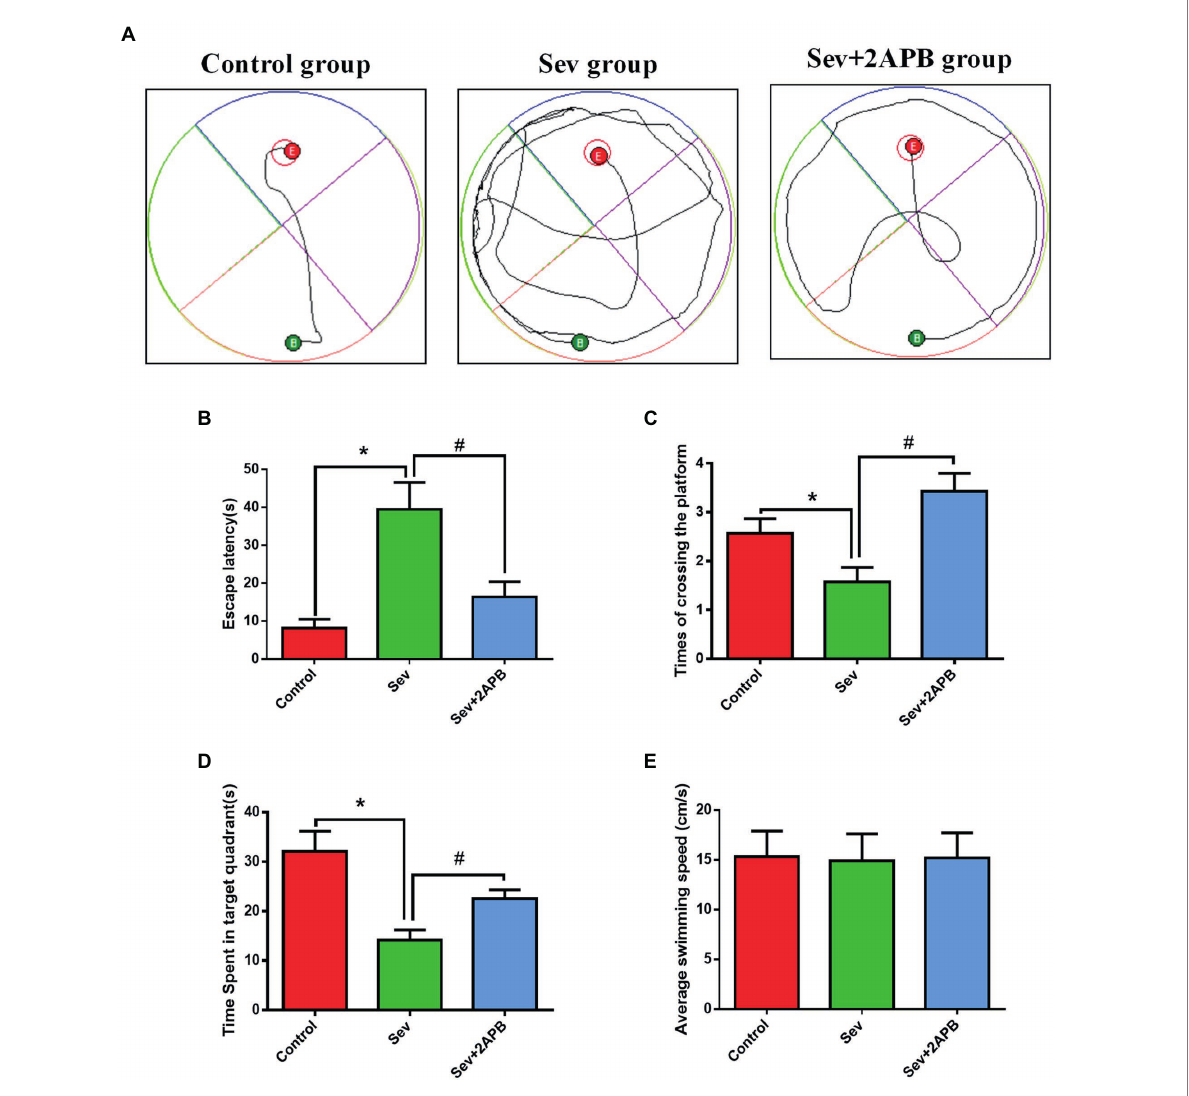
FIGURE 4 Sevoflurane impairs spatial learning and memory abilities in aged rats. ( A ) Swimming trajectory in the spatial exploration experiment. (B) Average escape latency. ( C ) Number of crossings of the platform area. ( D ) Time spent in the target quadrant. ( E ) Average swimming speed in the MWM test. Data are presented as mean ± SD ( n = 25 in each group). Compared with Control group, * p < 0.05; compared with Sev group, # p <